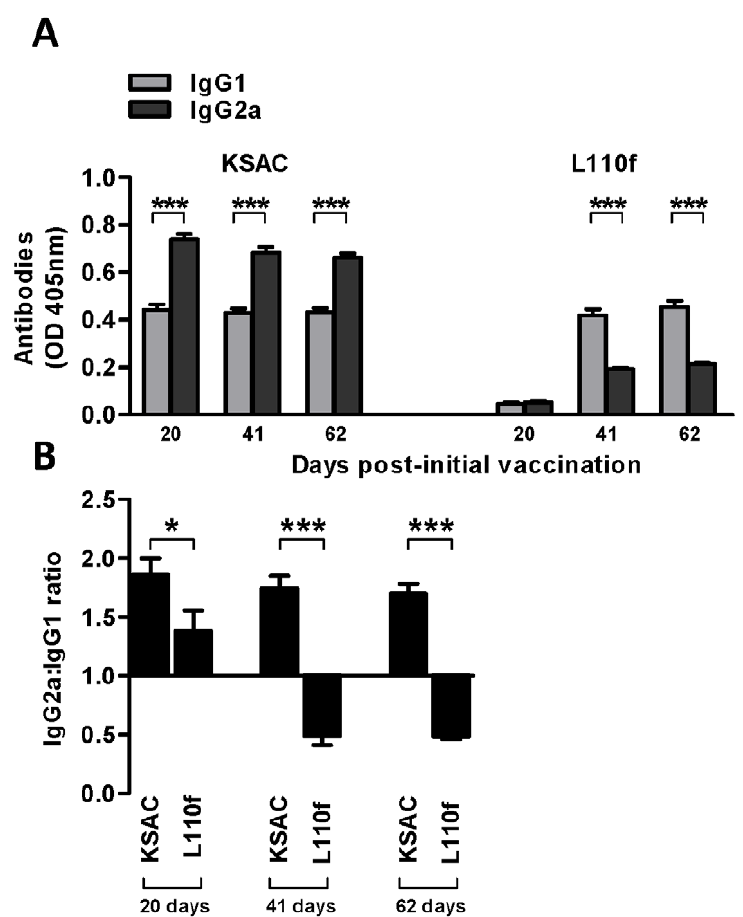
Figure 1. Antibody responses induced by vaccination with KSAC + GLA-SE or L110f + GLA-SE. BALB/c mice were vaccinated by the subcutaneous route three times every three weeks with either 20 m g adjuvant alone (GLA-SE), 10 m g KSAC + 20 m g GLA-SE, or 10 m g L110f + 20 m g GLA- SE. Serum was obtained one day before each immunization and 20 days after the last immunization. (A) KSAC- and L110f-specific IgG1 and IgG2a antibody levels in mice vaccinated with the respective antigen. (B) Ratio of antigen-specific IgG2a:IgG1 levels in mice vaccinated with KSAC + GLA-SE or L110f + GLA-SE. The OD values are presented after subtraction of the OD value of mice vaccinated with GLA-SE alone. Ten mice were used in each group. Data are representative of two independent